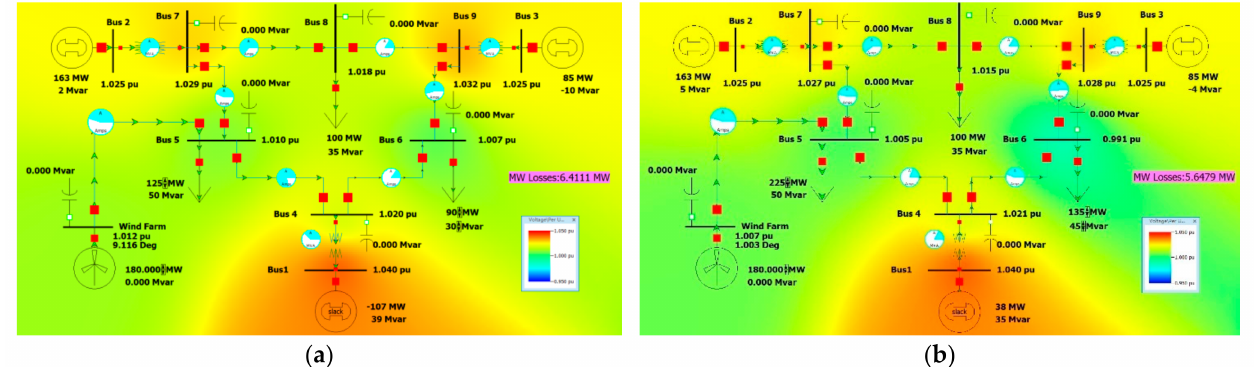
Figure 1. Simulation results with Tower A connected to bus 5 (25 km). ( a ) The results under the minimum load condition and ( b ) the results under the maximum load condition.